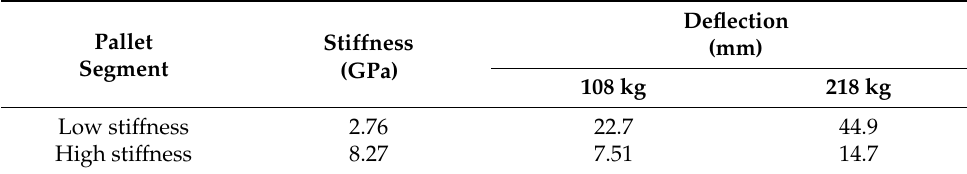
Table 4. Simulation results for low and high stiffness pallet segments deflection (mm) under uni- formly distributed